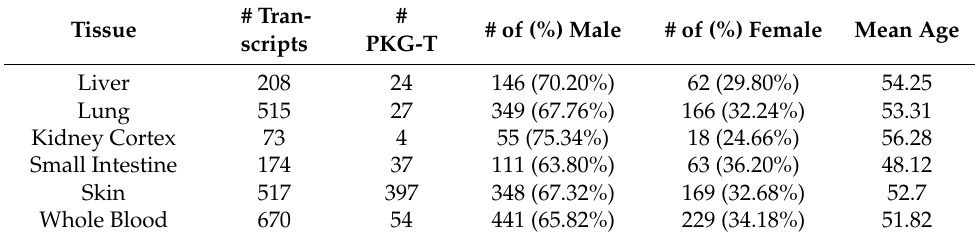
Table 1. The main characteristics of the dataset analyzed within this